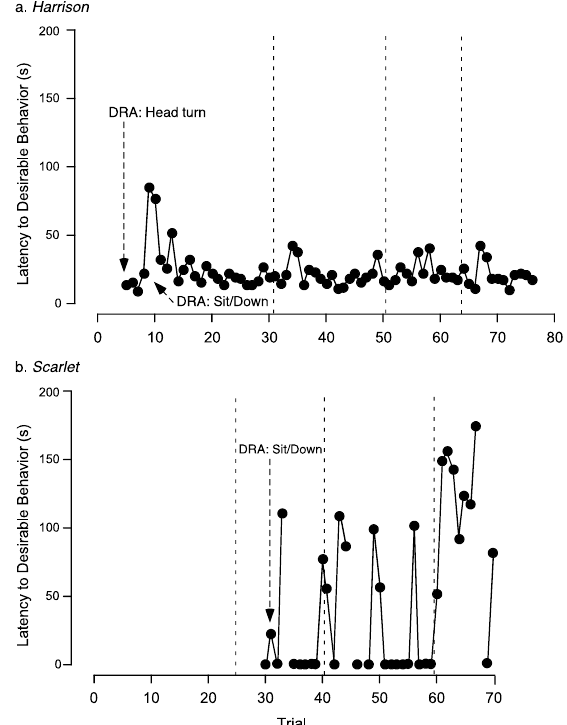
Figure 4. Latency to target desirable behaviors across trials for the two dogs ( a. Harrison; b. Scarlet) in the DRA condition. The trials on which the various DRA schedules were first started are indicated by arrows. Dotted vertical lines indicate the end of one session and the start of a new session. Latencies that are 0 indicate that the dog was engaged in the desirable behavior (e.g., lying down) as the owner left and did not get up when the owner left. Instead, it remained in that position and, after the specified interval of required good behavior elapsed, met the contingency for owner return.